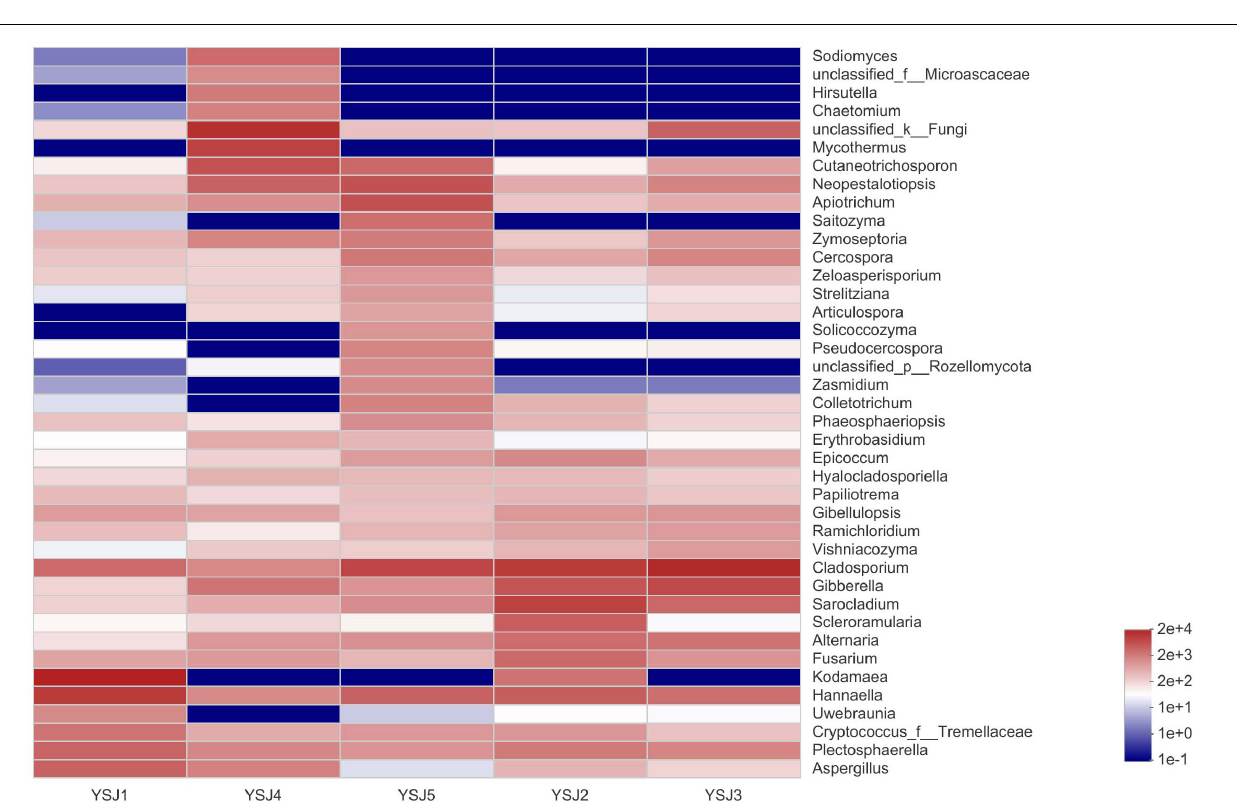
FIGURE 4 | Community heatmap analysis at the genus level. The bar on the right side represents the abundance value by color gradient.